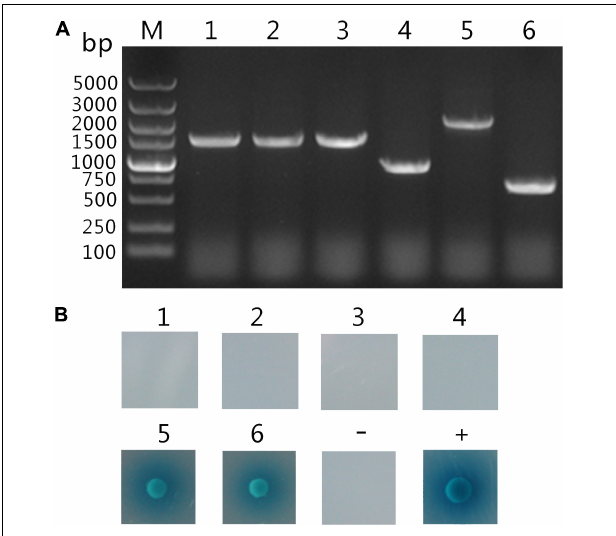
FIGURE 2 | Analysis of putatively positive colonies. (A) Analysis of PCR products of the inserts on putatively positive prey plasmids. M: DNA 5000 maker; Lane 1–6: PCR amplification products of the inserts on the six putatively positive hits. (B) Confirmation of putative hits. The pGBKT7-TaCyp1 bait plasmid was transformed with each of the six putatively positive prey plasmids (number 1 to 6) into Y2HGold cells. Meanwhile pGADT7-T and pGBKT7-Lam plasmids were co-transformed into Y2HGold cells for negative control, whereas pGADT7-T and pGBKT7-53 were co-transformed into Y2HGold cells for positive control. All co-transformants were grown on QDO/X/A plates, and positive interaction was indicated by the presence of blue colonies.